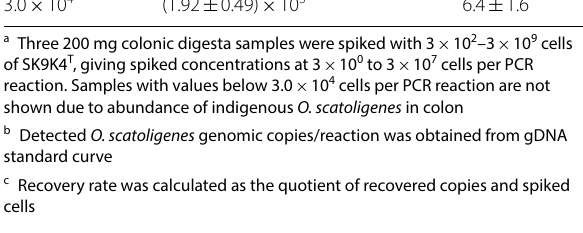
10 2 –3 10 9 cells × ×